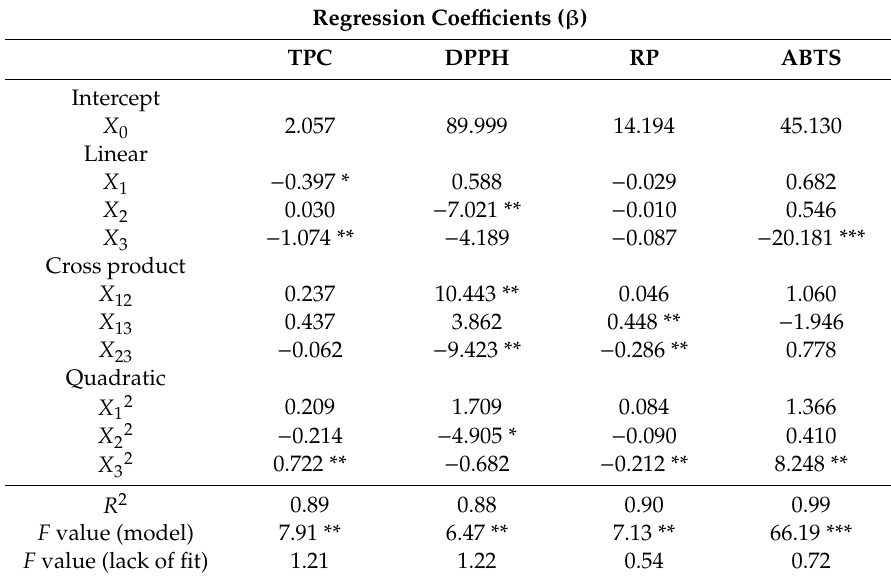
Table 2. Regression coe ffi cient ( β ), coe ffi cient of determination ( R 2 ), and F-test values of the predicted second order polynomial models for TPC, DPPH, RP, and